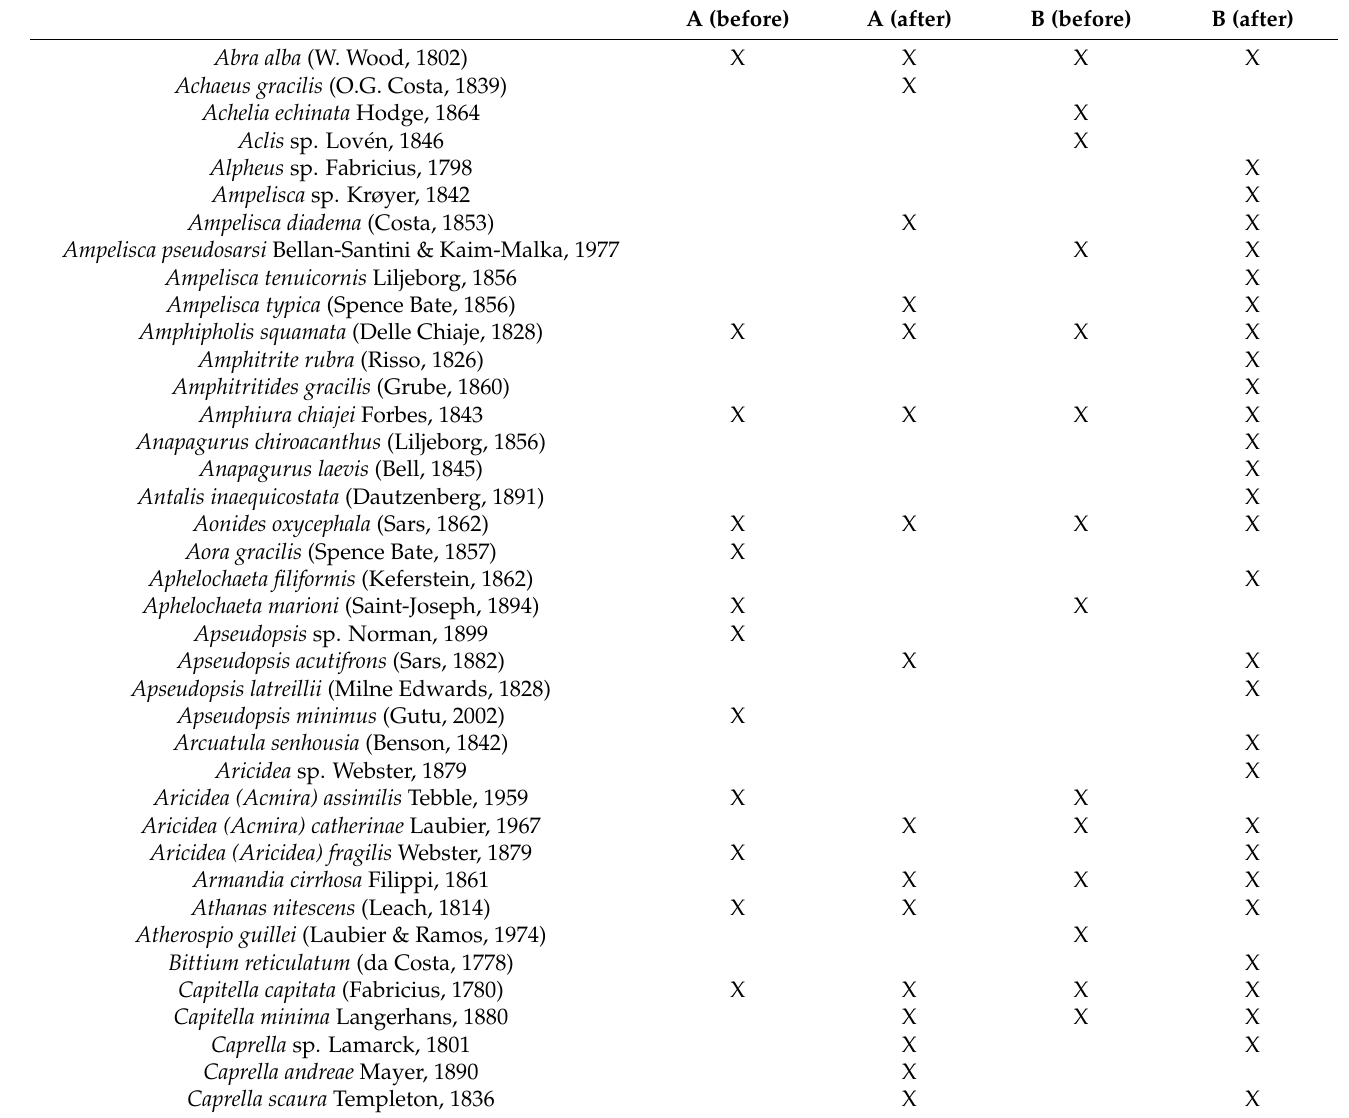
Table A1. Presence/absence list of the species recorded in the study area in site A and site B before and after the implementation of the IMTA system. X: